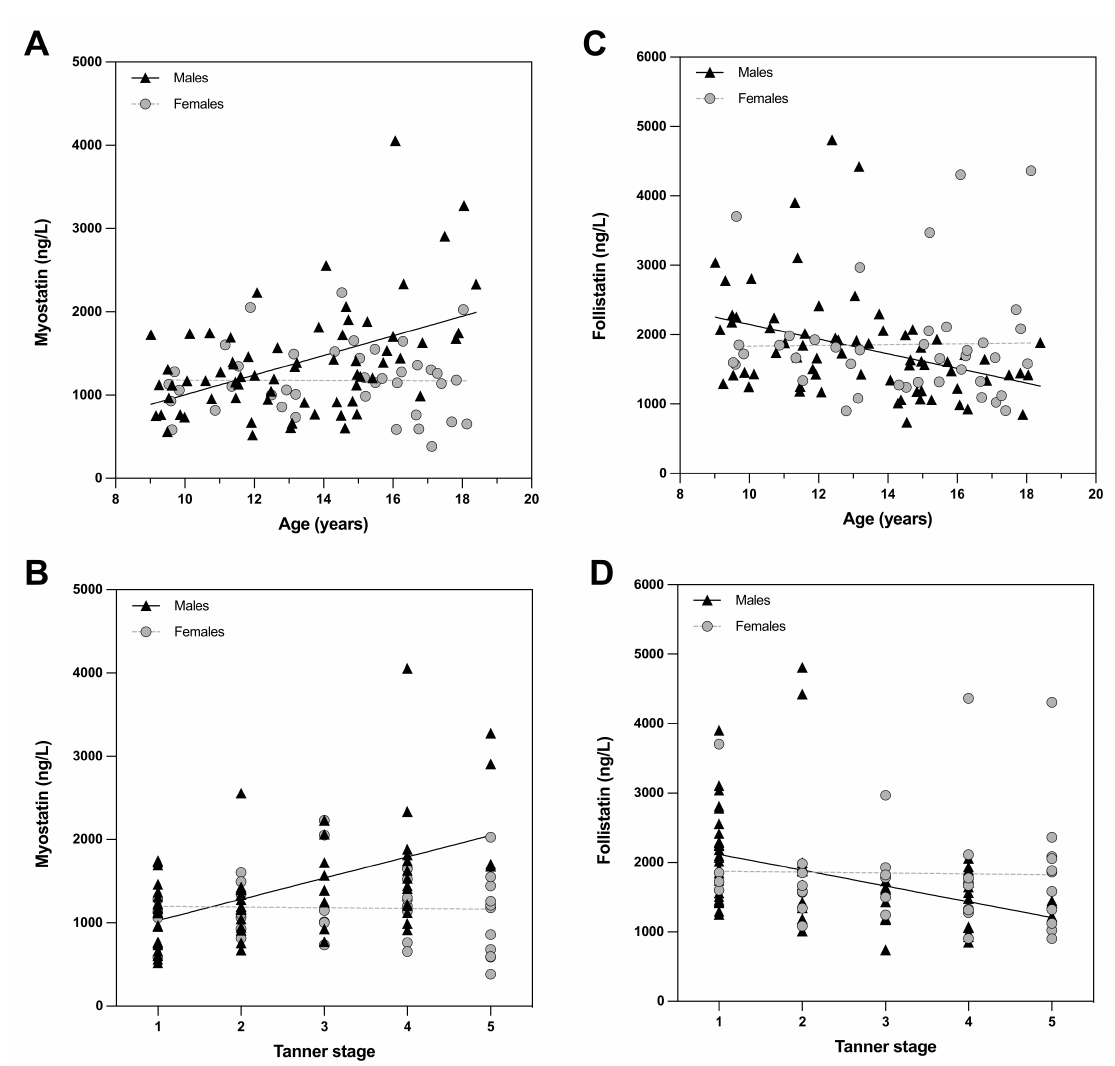
Figure 1. Correlations of myostatin with age ( A ) and Tanner stage ( B ) as well as follistatin with age ( C ) and Tanner stage ( D